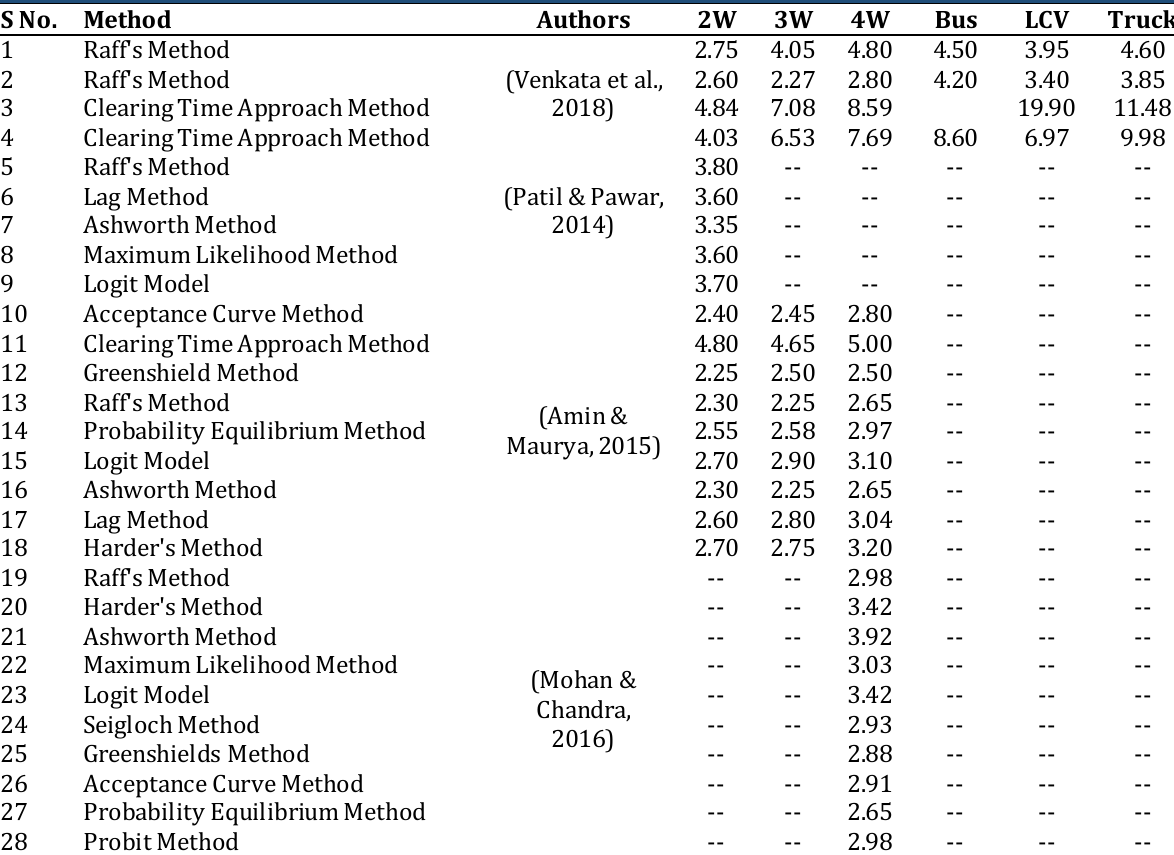
Table 4: Critical gap values for four-arm uncontrolled intersection for heterogeneous traffic condition S